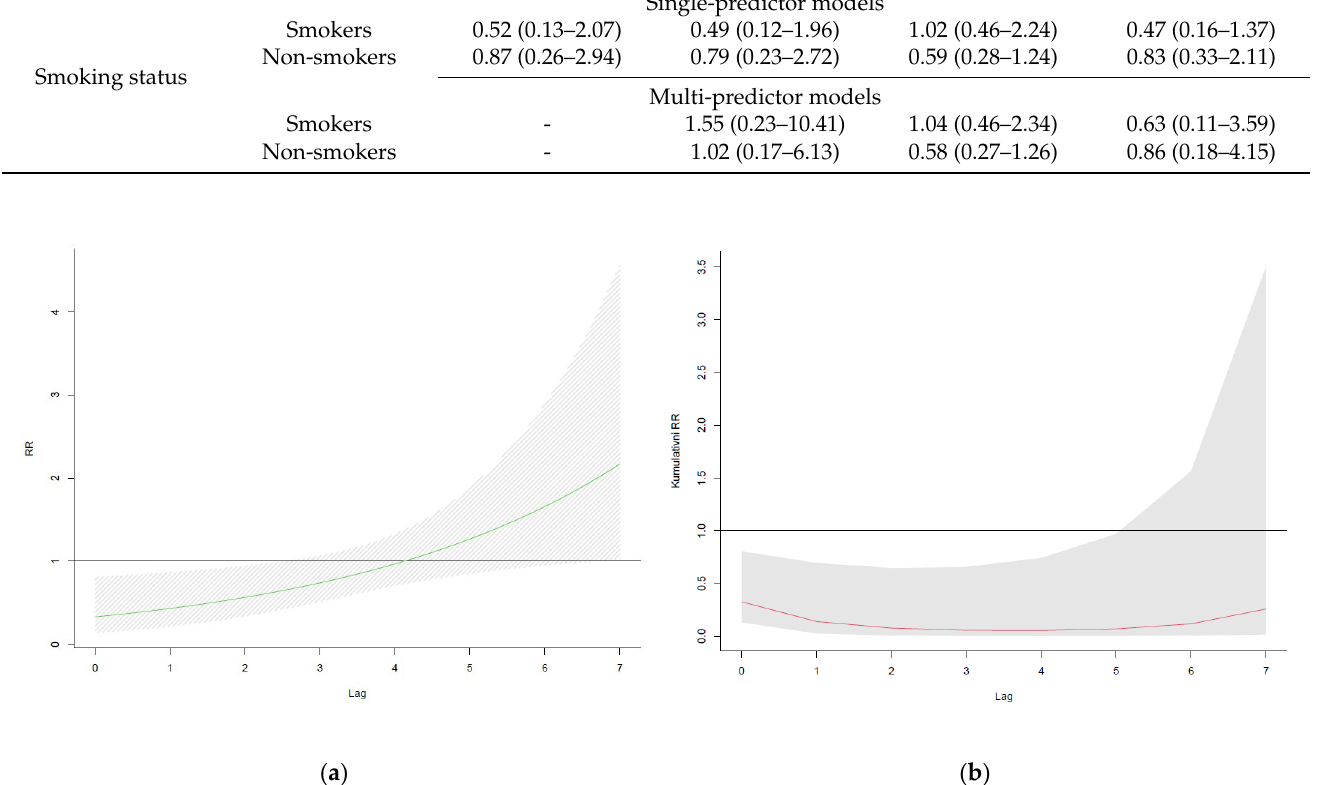
Figure 6. Effects of higher concentrations of PM 2.5 on RR for AECOPD hospitalizations among active smokers: ( a ) lag association curve for PM 2.5 concentration of 140 μg/m 3 . This figure shows